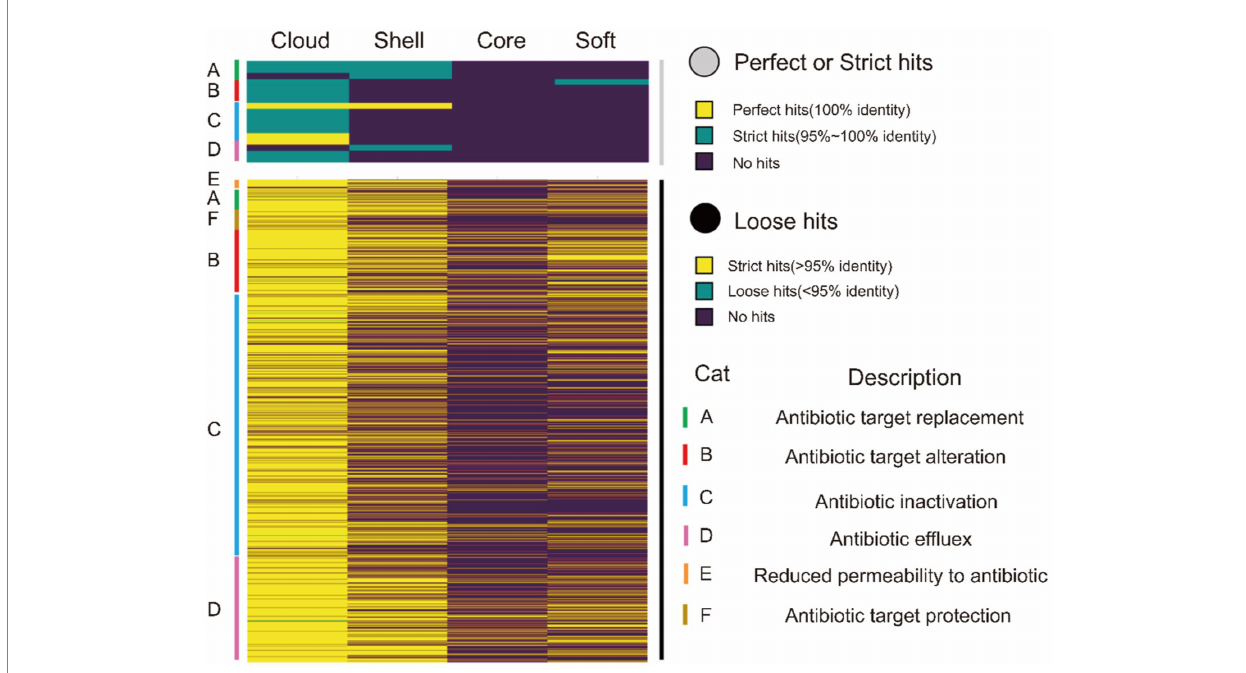
FIGURE 4 CARD annotation of the core genome and the accessory genome. The upper heatmap (gray) is the annotation result obtained using perfect or strict mode, yellow represents 100% agreement, green represents 95 ~ 100% agreement, and purple represents no match. The lower heatmap shows the annotation results obtained using loose mode, with >95% agreement in yellow, <95% agreement in green, and no match in purple. The right side of the heat map is marked as A ~ F, and there are 6 types of drug resistance